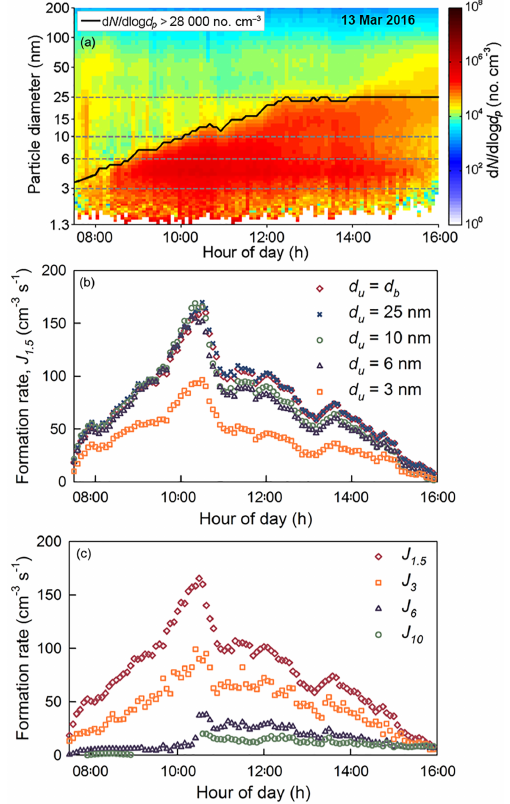
Figure 2. Comparison of formation rates estimated using differ- ent upper bounds, d u . (a) A typical new particle formation event. Dashed gray lines represent different d u values in Eq. (1). Solid black lines corresponds to d b , i.e., the varying upper bound deter- mined by d N /dlog d p . (b) Estimated formation rates with different upper bounds, d u , using Eq. (1). (c) Estimated formation rates with different d k values using Eq. (1); d u equals 25nm and d min equals 1.3nm in the four scatter